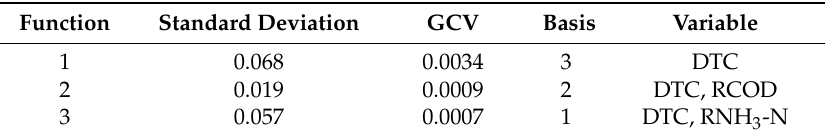
Table 3. Results of ANOVA decomposition in construction cost. Function Standard Deviation GCV